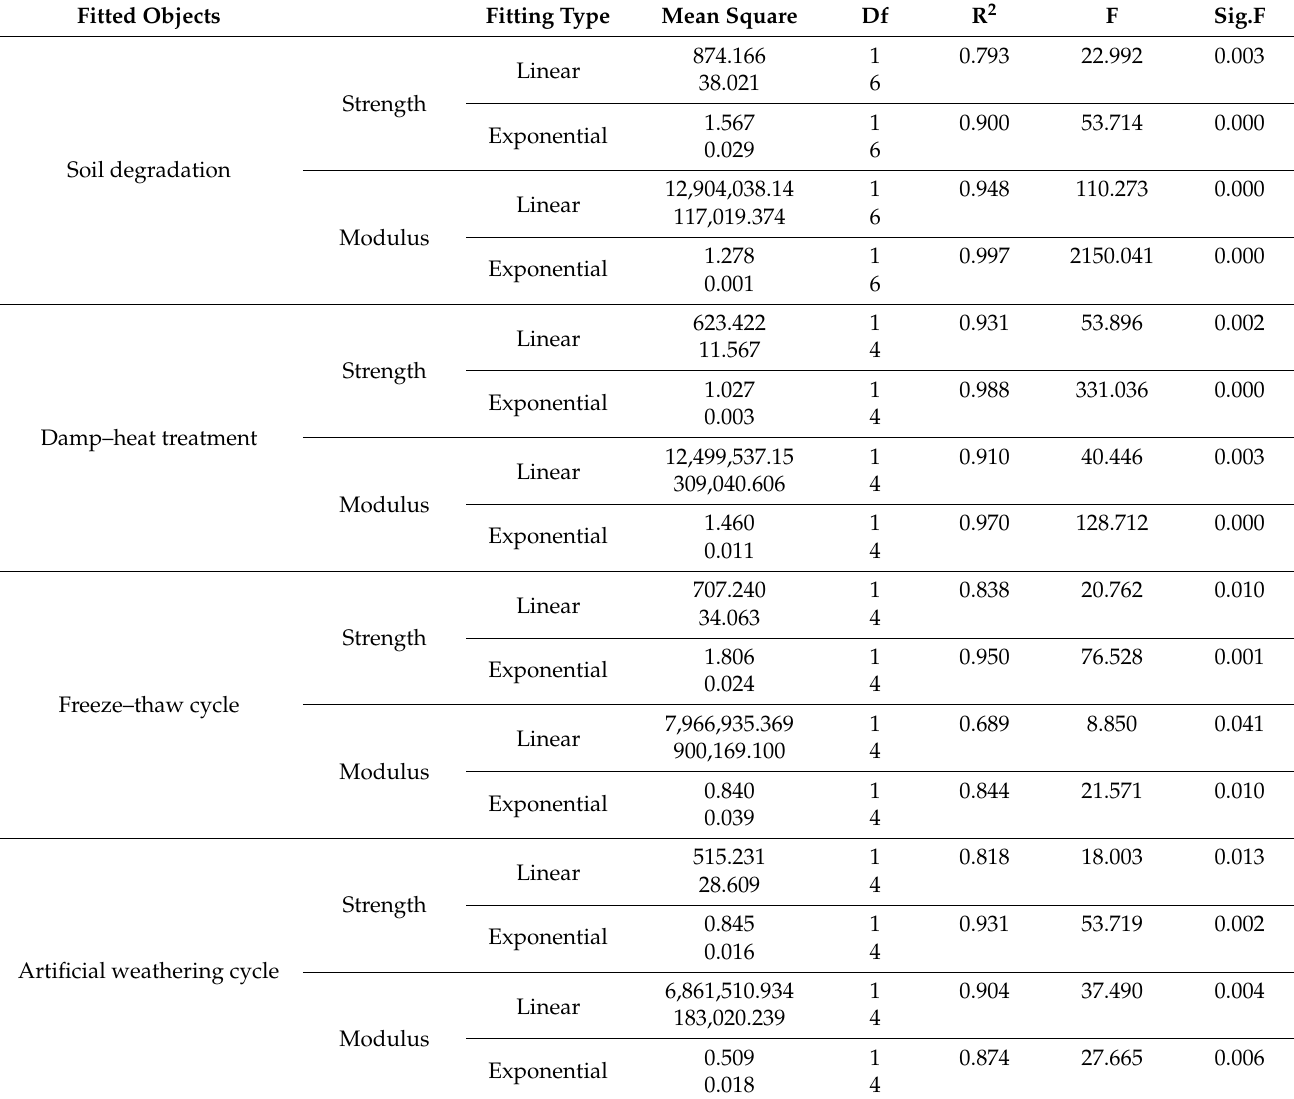
Table 2. Curve estimation results and significance test of tensile strength after soil burial